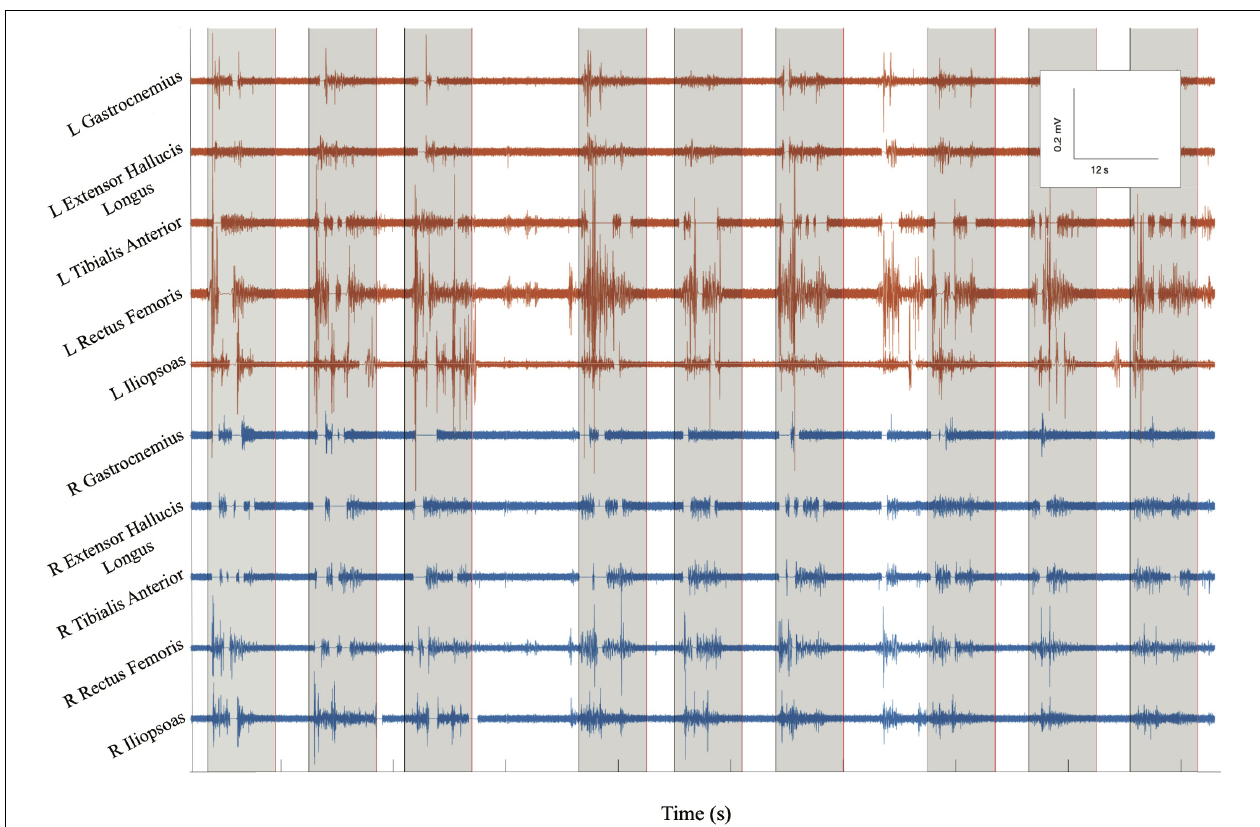
FIGURE 5 | BMCA at Subject 2’s follow-up visit 13: surface EMG electrical activity recorded in volts over time for eight bilateral lower extremity muscle groups. Orange traces include left muscle groups and blue traces include right muscle groups. Gray boxes indicate volitional task events signaled by auditory cues. This subsample of EMG recording includes three cues for bilateral hip flexion, right hip flexion, and left hip flexion, respectively. EMG bursts can be seen to be synchronized with the auditory cue followed by silent periods at rest, demonstrating volitional